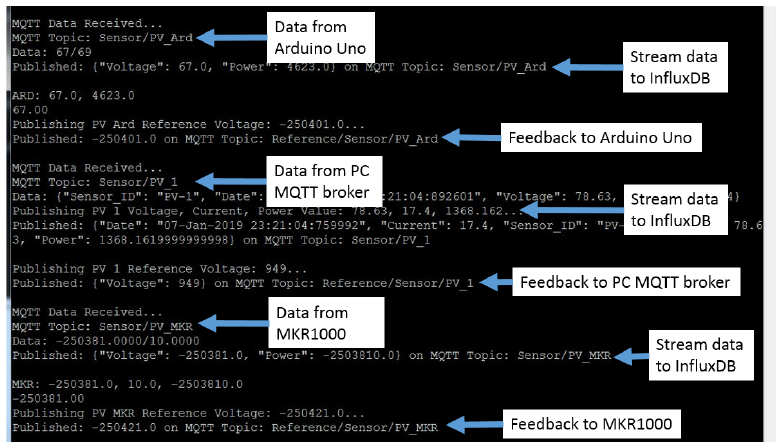
Figure 12. The data transmission between MKR1000, Arduino Uno and PC MQTT broker with Raspberry Pi3 and InfluxDB